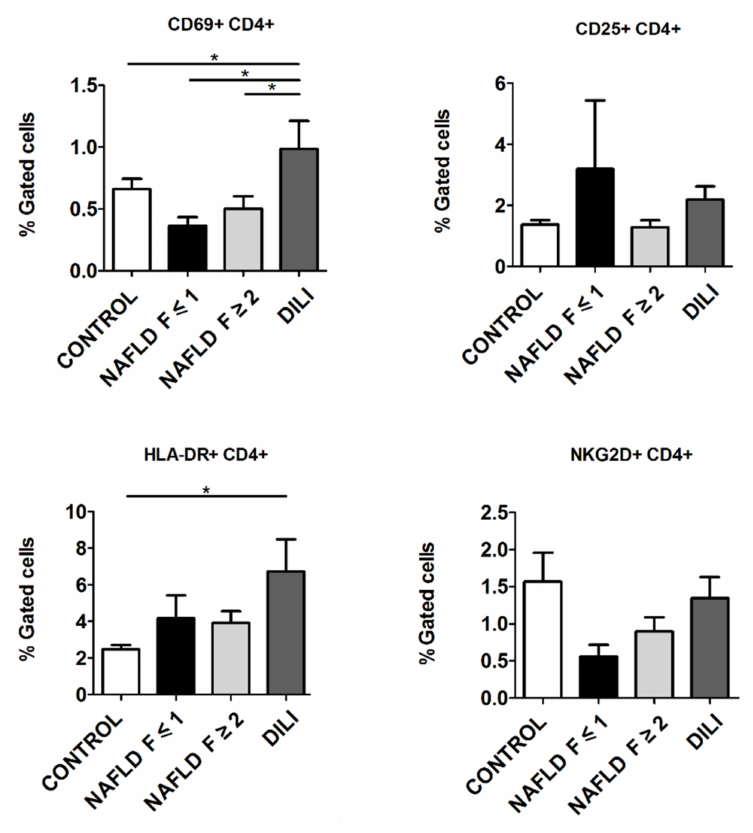
Figure 3. Expression of early (CD69+) and late (CD25+, HLA-DR+) activation markers, and NKG2D+ in CD4+ T cells in T lymphocytes from peripheral blood mononuclear cells from healthy controls, non-alcoholic fatty liver disease (NAFLD) and drug-induced liver injury (DILI) patients. Data are presented as mean ± standard error of the mean. * p ≤